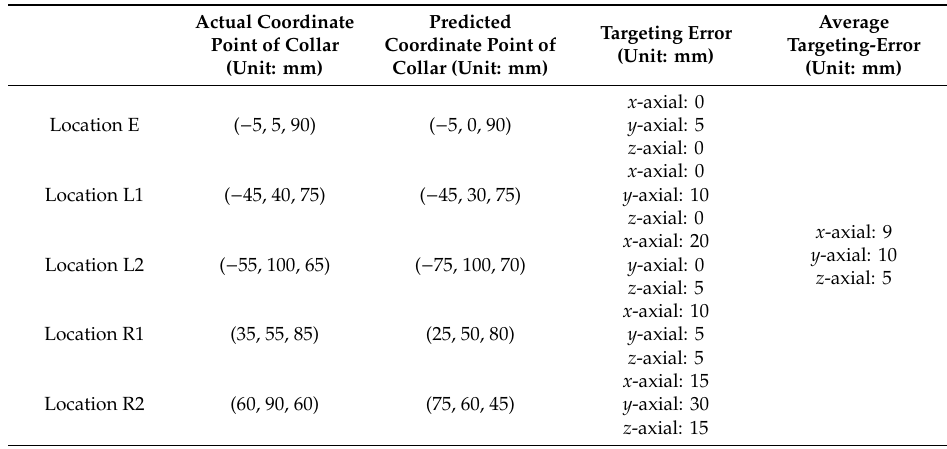
Figure 9. The test results of the system: the isometric view and top-plane view of curve-fitting-predicted voltage outputs of the receiving electromagnets when the collar moves to ( a ) location E, ( b ) location L1, ( c ) location L2, ( d ) location R1, and ( e ) location R2 in the bronchi-tree model. Table 1. Summary of testing results: Actual coordinate points, predicted coordinate points, and targeting